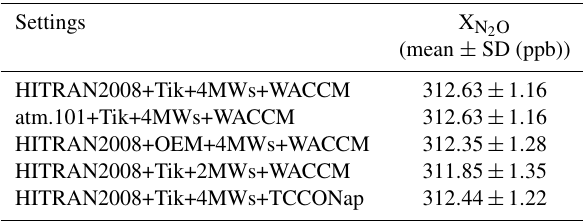
measurements. 2 O